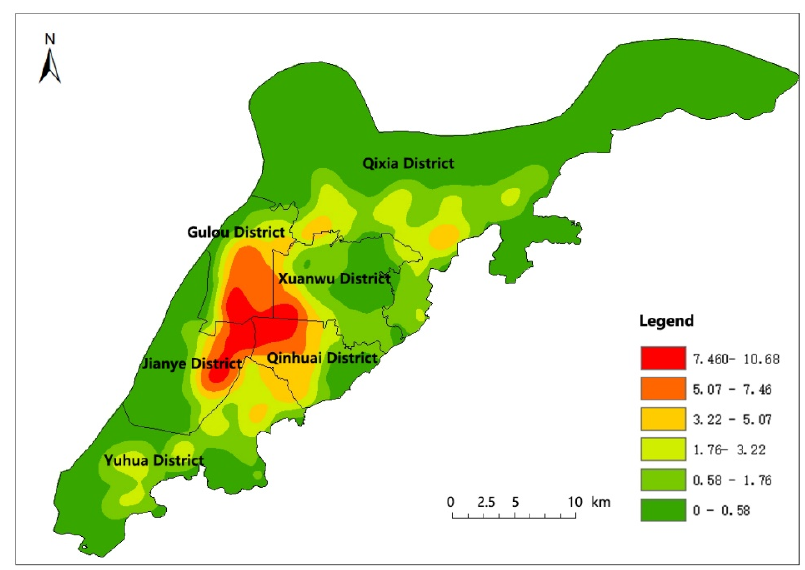
Figure 3. Kernel analysis for number of PBS stations.